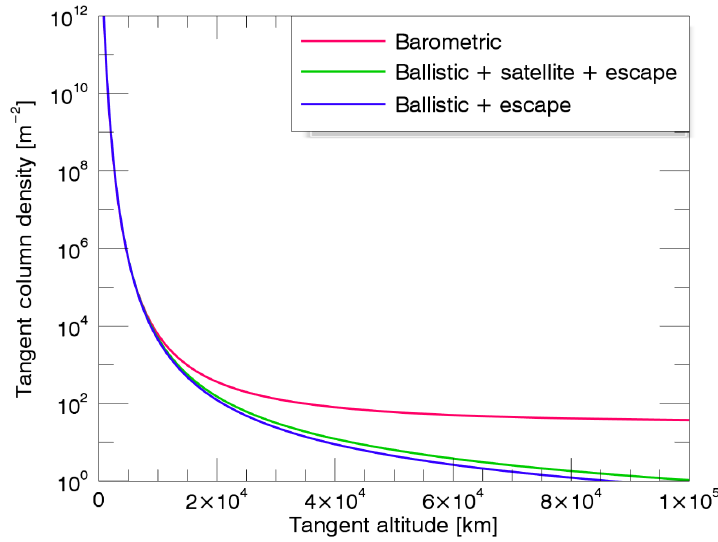
Figure A1. Examples of the TCD profiles for sodium for an exobase temperature of 594K using the Chamberlain model. The pink curve represents the density profile for the barometric law; the green curve represents a combination of ballistic, satellite, and escape orbits; and the blue curve represents density profiles including ballistic and escaping particles.